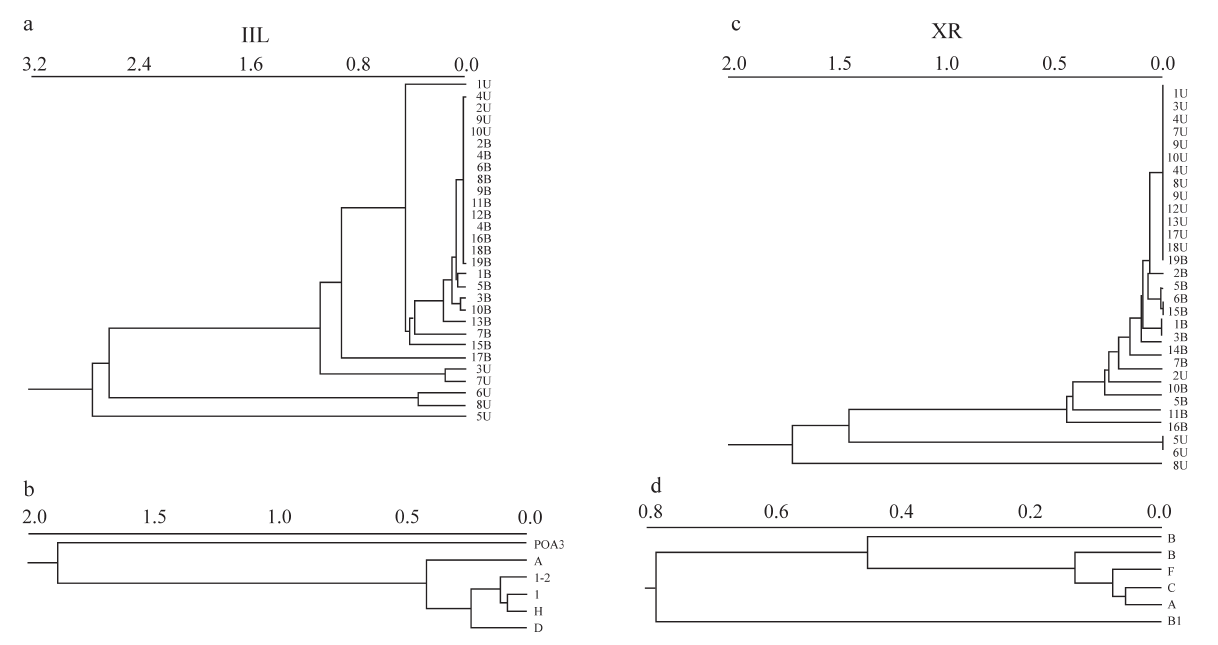
Figure 2 - Relationships among D. willistoni populations from Uruguay and Rio Grande do Sul based on the similarities/dissimilarities of the inversions onchromosomearmsXL(a,b)andXR(c,d)usingtheUPGMAmethod.(a)ClusterbasedonthefrequenciesofheterozygousinversionsinXLand(b)the contribution of each type of XL inversion to the clustering in (a). (c) and (d), as in (a) and (b) but for chromosome arm XR. Population samples as in Ta- bles 2 and